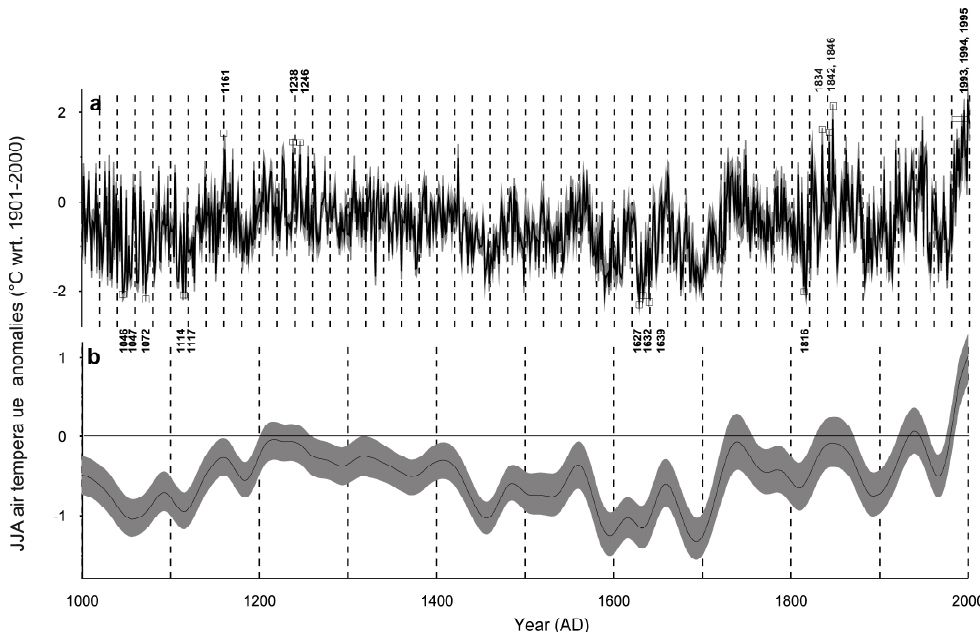
Figure 5. Alpine summer temperatures reconstruction (a) with the white boxes denoting the warmest and coldest years, and the smoothed black line (b) being a 20-year low pass filter with 95% bootstrap confidence limits (gray). Temperatures are expressed as anomalies with respect to 1901-2000.